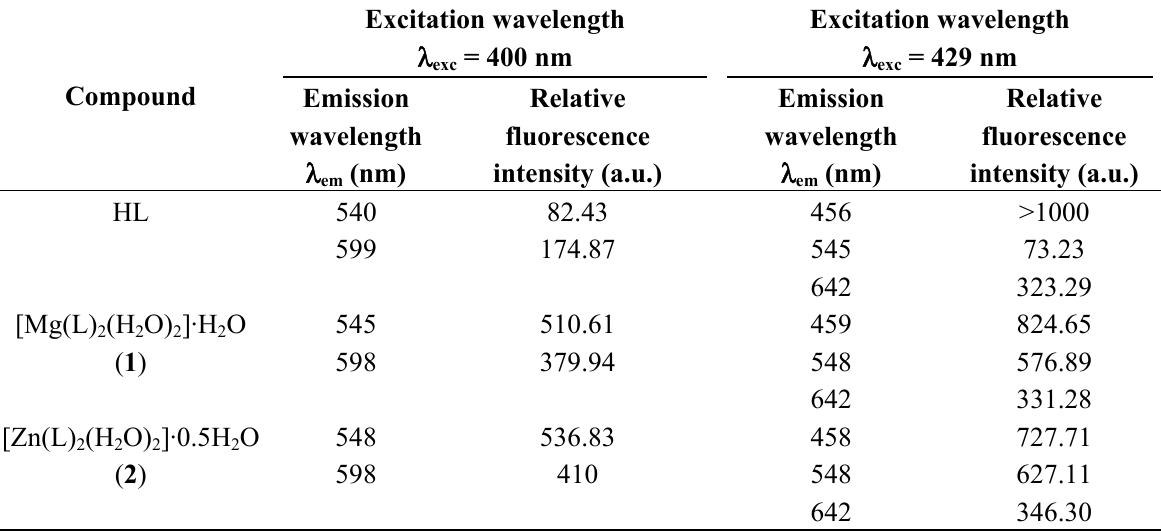
Table 9. Fluorescence data for ligand and